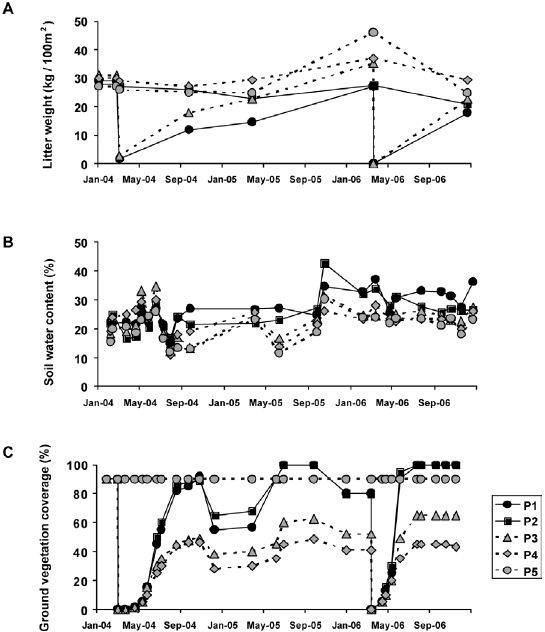
Fig. 1. Environmental changes after vegetation manipulations from 2004 to 2006. (A) litter dry weight, (B) soil water content, (C) ground vegetation